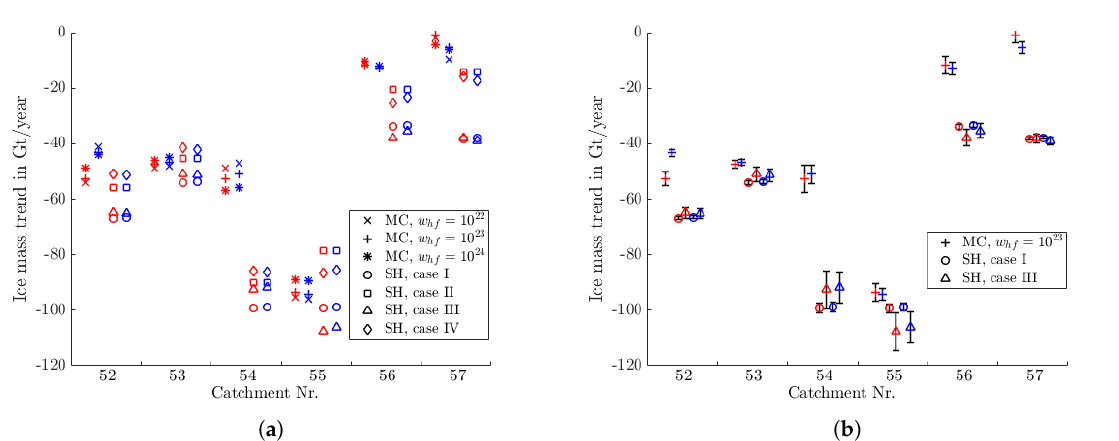
Figure 18. Visualization of the ice mass trend values obtained by the mascon (MC) and SH approaches for the 6 catchment areas in Greenland (see Figure 7). Red (blue) symbols represent results based on GRACE-only (GRACE/GOCE combination) models. Panel ( b ) shows a selection of the datapoints shown by panel ( a ), including the 1-sigma error bars which are computed by formal error propagation of the covariance matrices of the respective gravity field models (and partly based on the factor w hf , in the case of the mascon results). The SH cases I to IV refer to SH coefficient combinations and are defined in Table 1. The underlying mascon models have a resolution of 2 ◦ over the land and 4 ◦ over the ocean areas, as shown by Figure 6. The high-frequency weighting factor w hf is explained in the text. All trend and trend error values are listed in Table